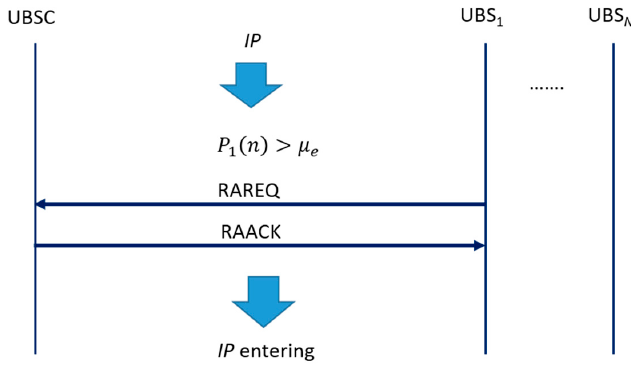
Figure 6. Queue-overflow and insufficient reserved capacity of a UBSC case of the normal operation phase.